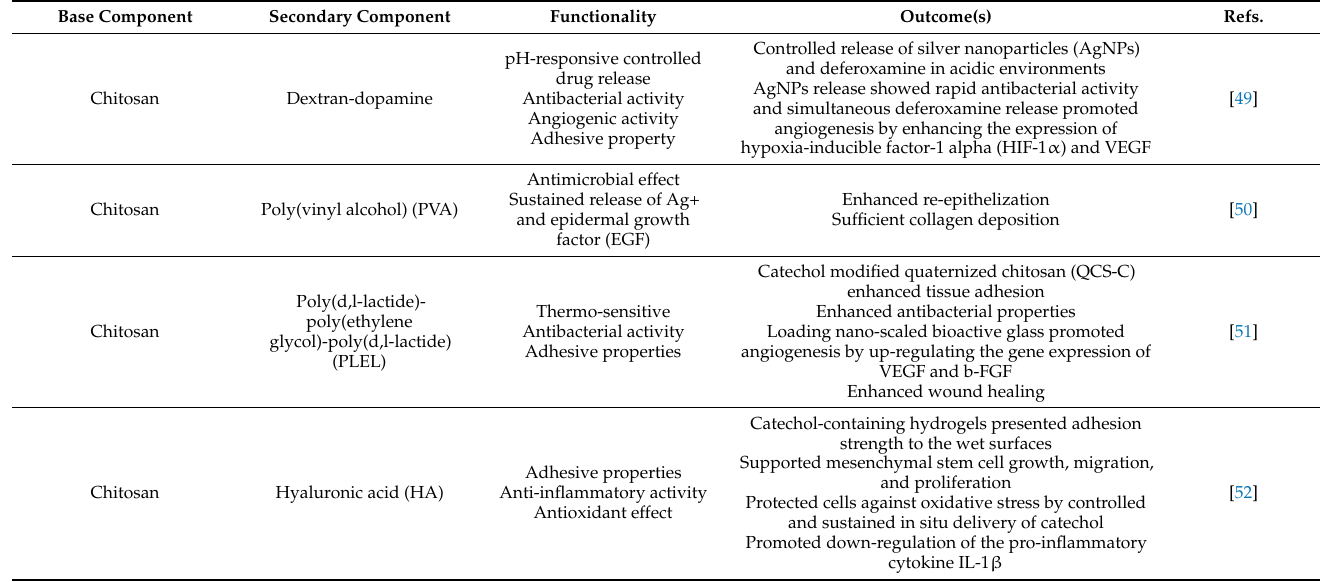
Table 4. Hybrid hydrogels as functional wound